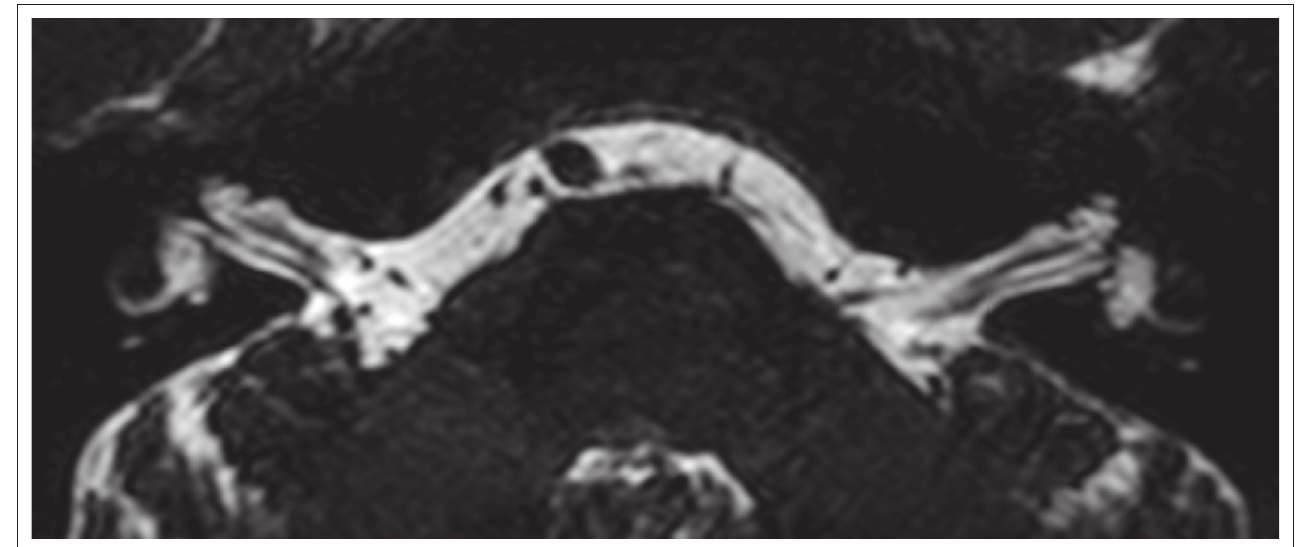
FIGURE 2: Axial T2-weighted MRI of the inner ear, internal auditory canal and cerebellopontine angle. Describe the relevant imaging findings and formulate the most appropriate clinical diagnosis. Please submit your response to misser@lakesmit.co.za not later than 31 July 2015. The